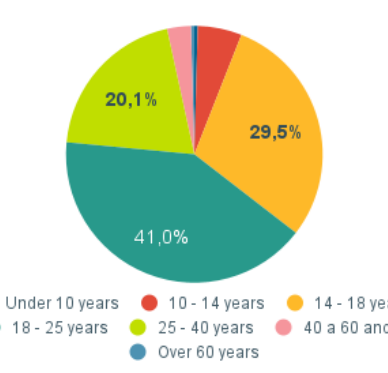
Figure 10. The character of the fourth phase - Durga.